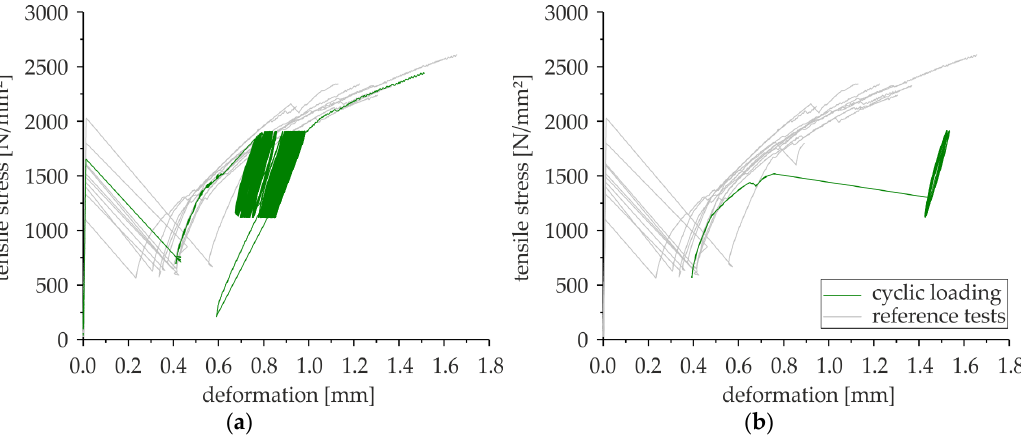
Figure A2. Cyclic stress–deformation curves (here: anchorage length = 2 a ): ( a ) non-failed specimen; ( b ) failed specimen (load cycles: 5308).